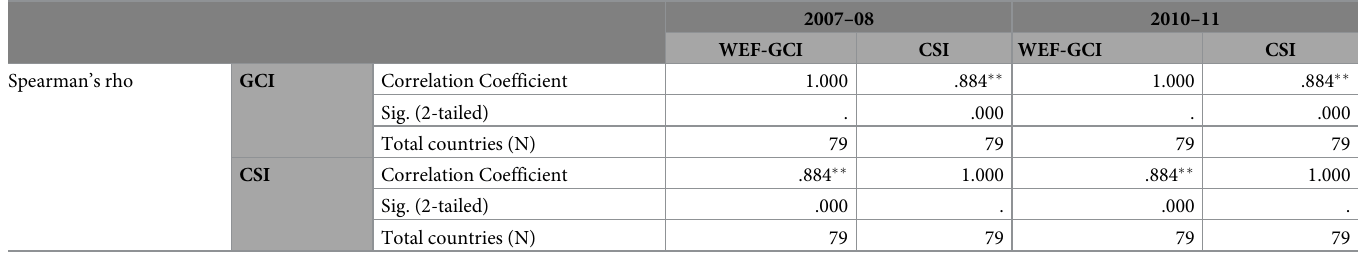
Table 8. Spearman’s rho: Correlation between the WEF-GCI and CSI.